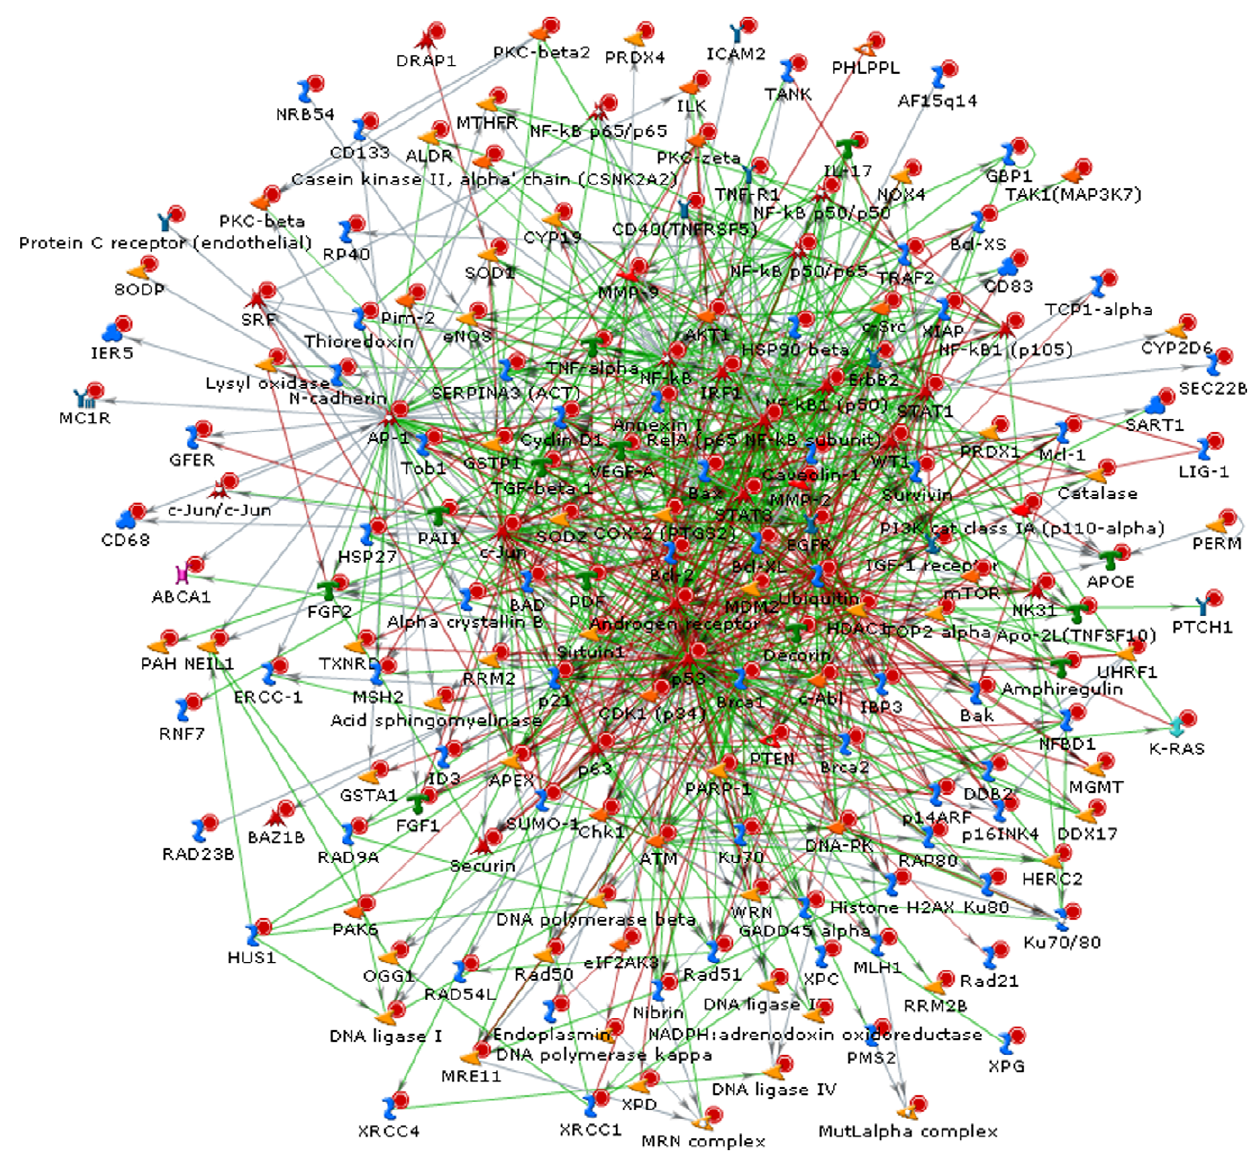
Figure 1. Direct protein-protein interaction network. A network representation that illustrates the complexity of direct connections among genes identified via literature review.